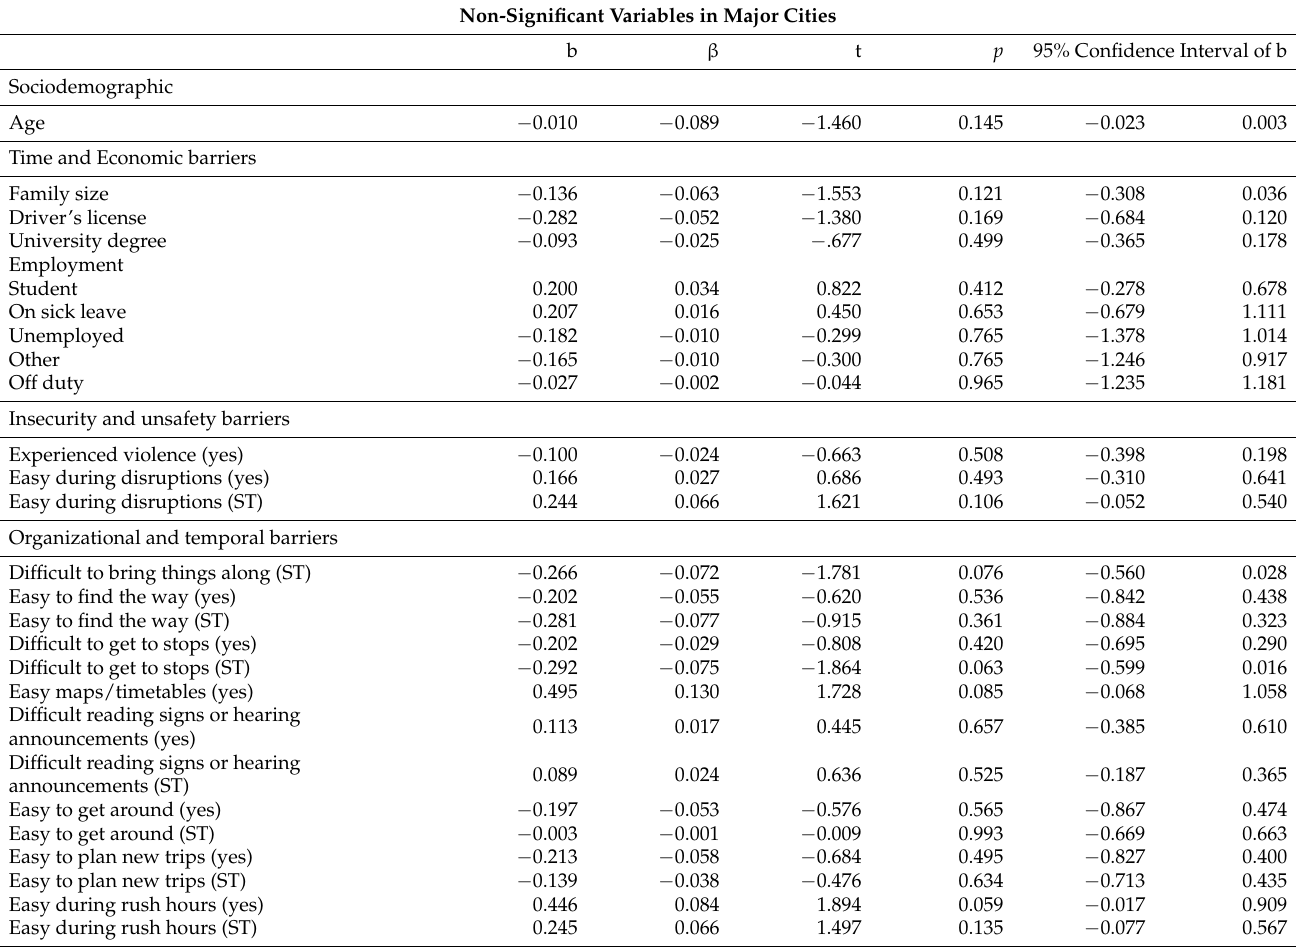
Table A1. Non-significant variables during regression analysis of perceived accessibility to public transport in major cities ( N = 453).